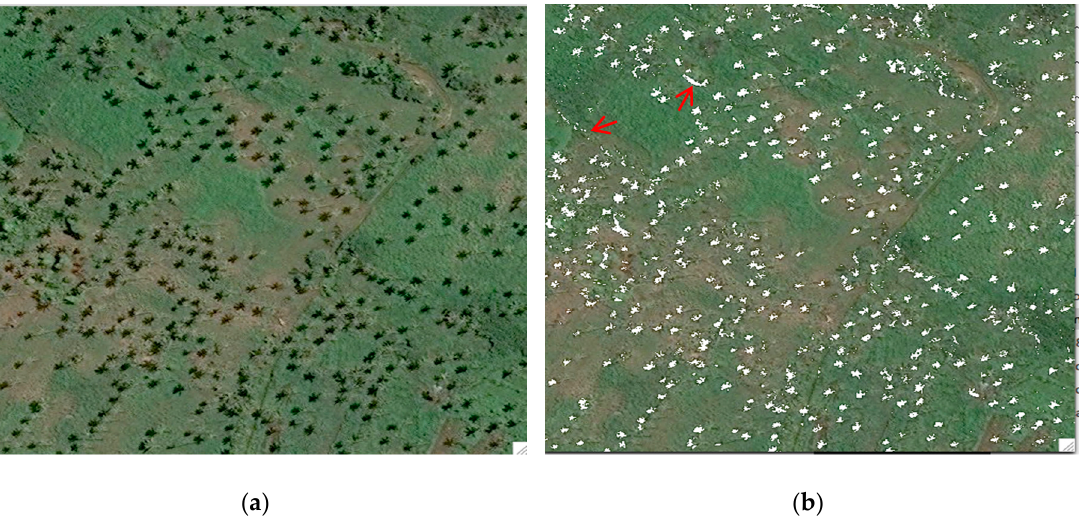
Figure 1. ( a ) Details of the true color image acquired by WorldView-3 at 30 cm showing coconut trees and their shadows. ( b ) The shadows are automatically detected using a simple threshold algorithm and shown in white. The red arrows point to areas where shadows are detected, but are either too small or too large to be coconut trees.